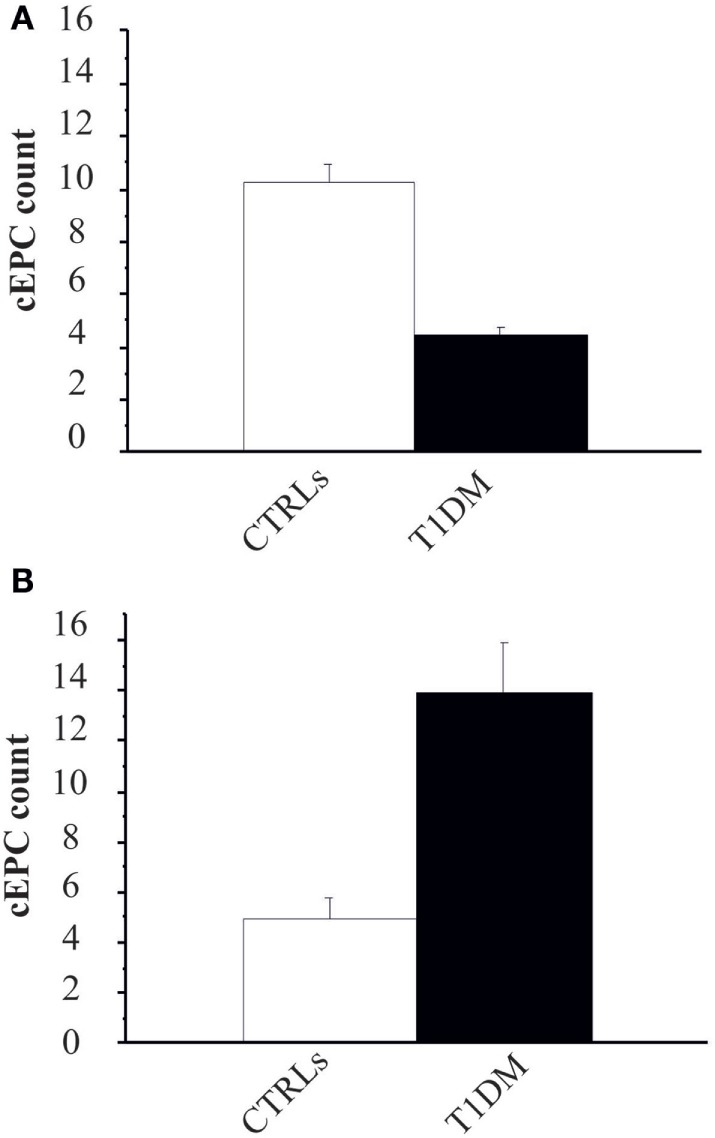
(A) Circulating endothelial progenitor cell (cEPC) counts (absolute cEPC number per 2 × 105 peripheral blood mononuclear cell) in adult control subjects (white bar) and adult type 1 diabetes mellitus (T1DM) (black bar). Data are reported as mean ± SEM; p < 0.001, Student’s t-test. (B) cEPC count in childhood/young control subjects (white bar) and age-matched T1DM (black bar). Data are reported as mean ± SEM; p < 0.001, Mann–Whitney U test.